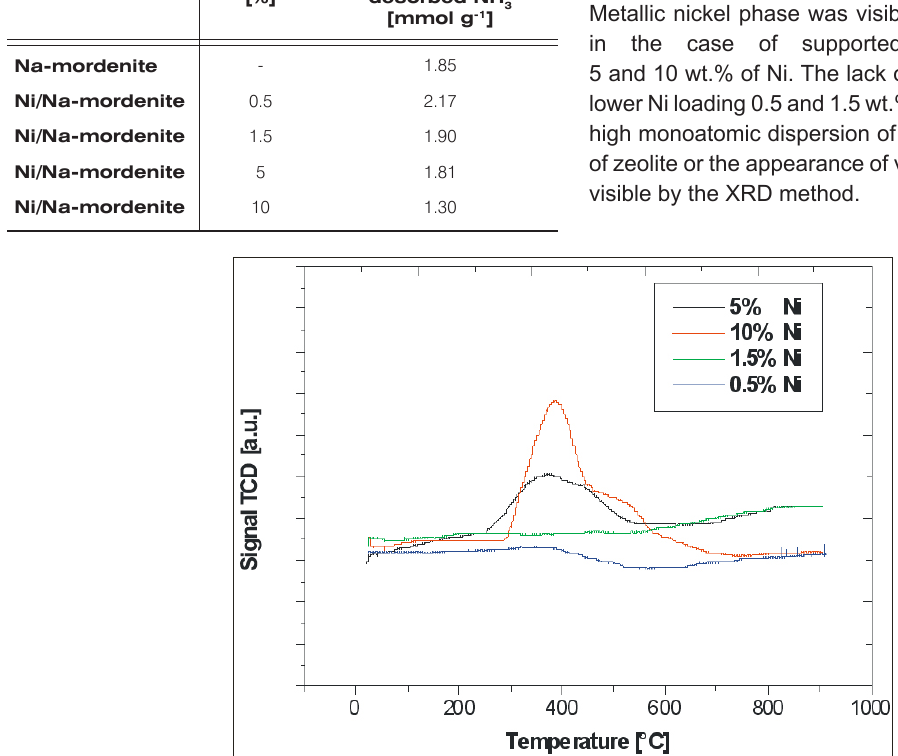
Figure 2. Temperature programmed reduction measurements for Ni/Na-Mordenite